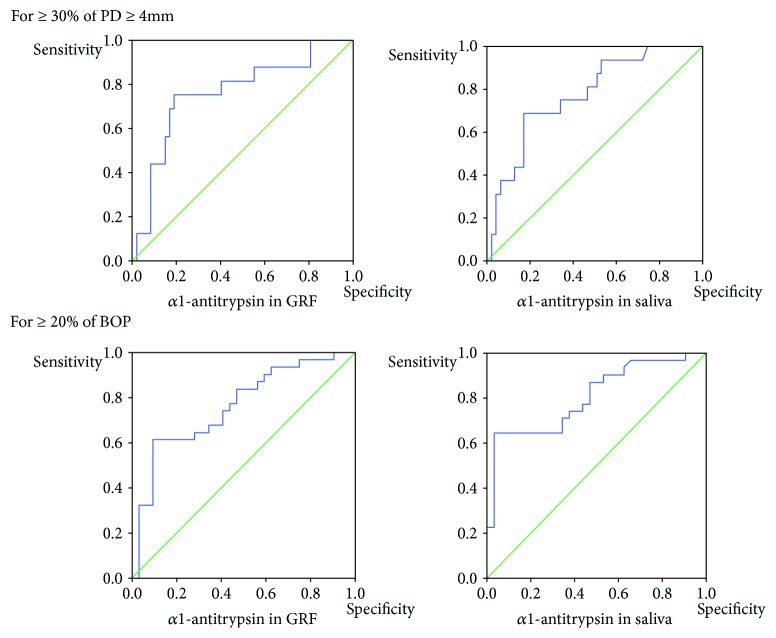
ROC curve analysis of α1-antitrypsin in GRF or in saliva.